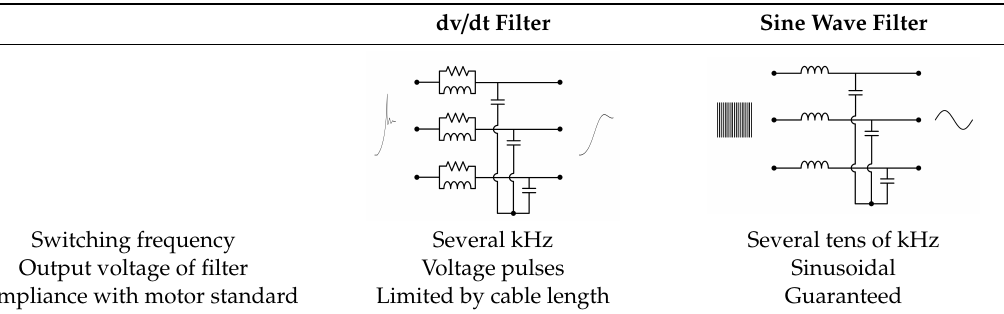
Table 1. Comparison of dv / dt filter and sine wave filter.